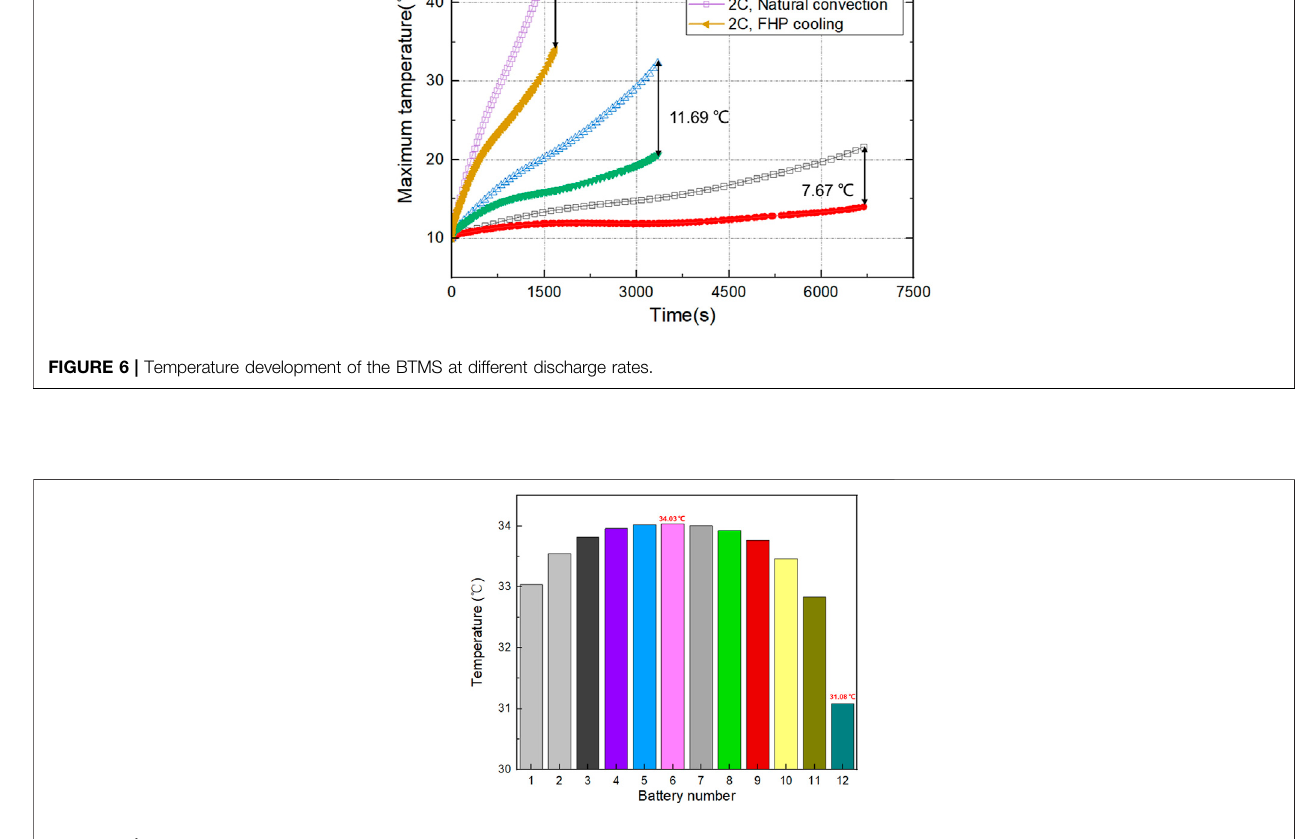
FIGURE 7 | Temperature variation of the battery cells at the end of 2C